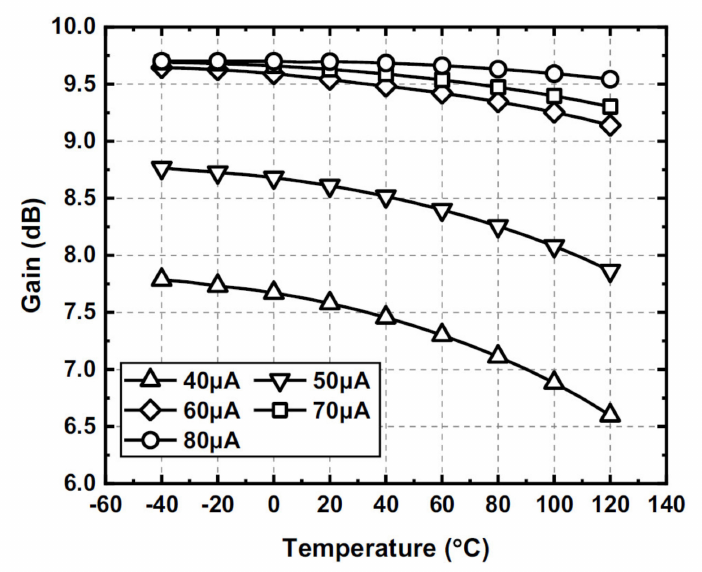
Figure 10. The simulated gain at 100 MHz of the proposed gain cell with different operating tempera- tures and biasing currents.